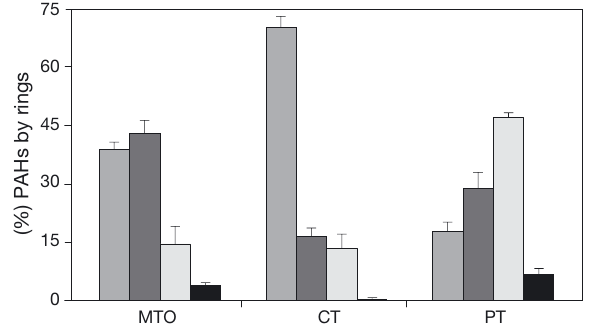
Fig. 2. Hydrocarbon families contained in different tar mix- tures used to clean mussel rafts as a percentage of the total PAHs ( Σ 13 PAHs). Error bars = 1 SD. Significant variation (p < 0.01; Tukey’s test). j 3-ring PAHs; j 4-ring PAHs; j 5- ring PAHs; j 6-ring PAHs. MTO: mixture of petroleum tars and diesel combusted oil; CT: coal tar; PT: tar of pine